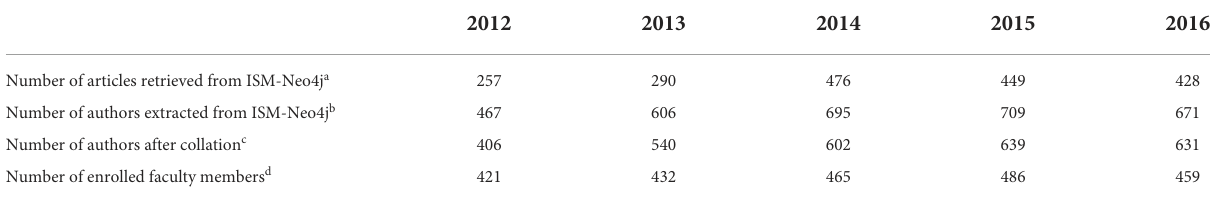
TABLE 1 Description of